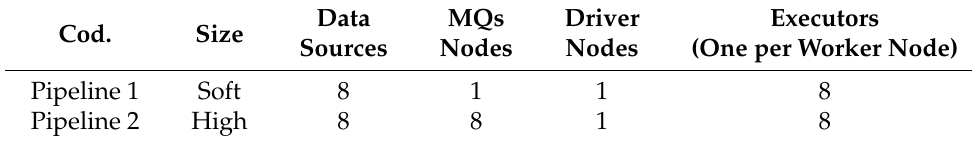
Table 5. Pipeline